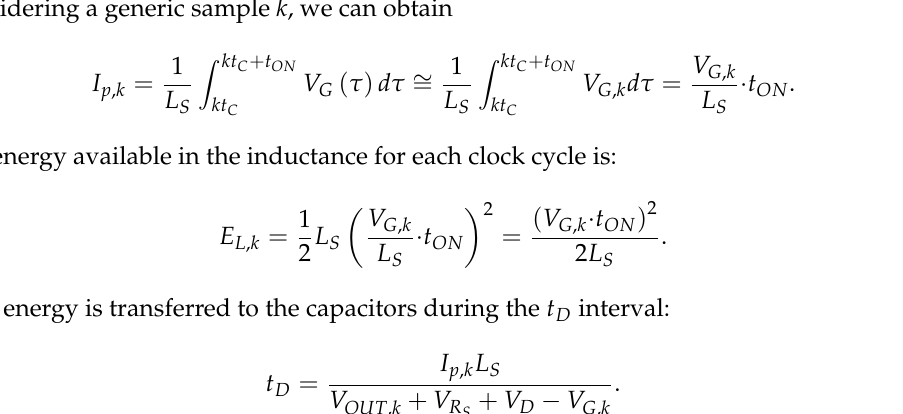
Figure 9. Complementary switched inductor converter. C1 is charged when V G is positive, C2 when is it is negative.